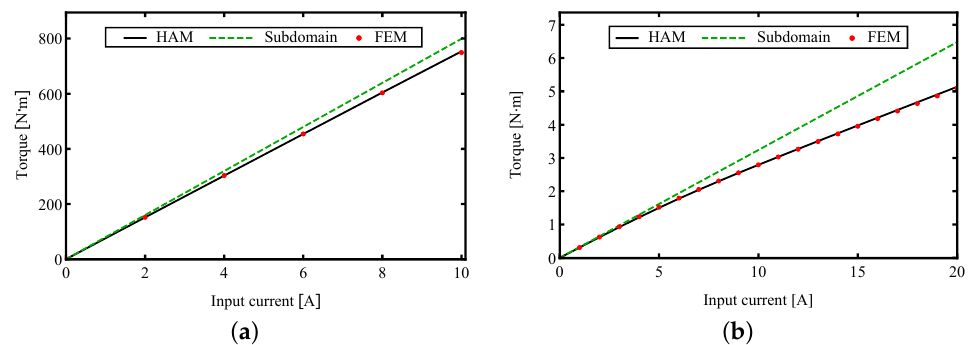
Figure 20. Comparison of electromagnetic torque as a function of the maximal current in the winding: ( a ) Machine I and ( b ) Machine